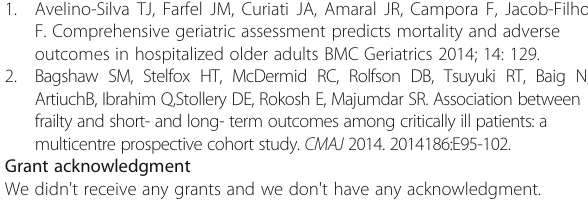
5 cmH 2 O (ml); lung inhomogeneities were computed as previoulsy described [2]. Intratidal collapse and decollapse was defined as the difference in not inflated tissue between end-inspiration and end- expiration expressed as fraction of total lung weight.